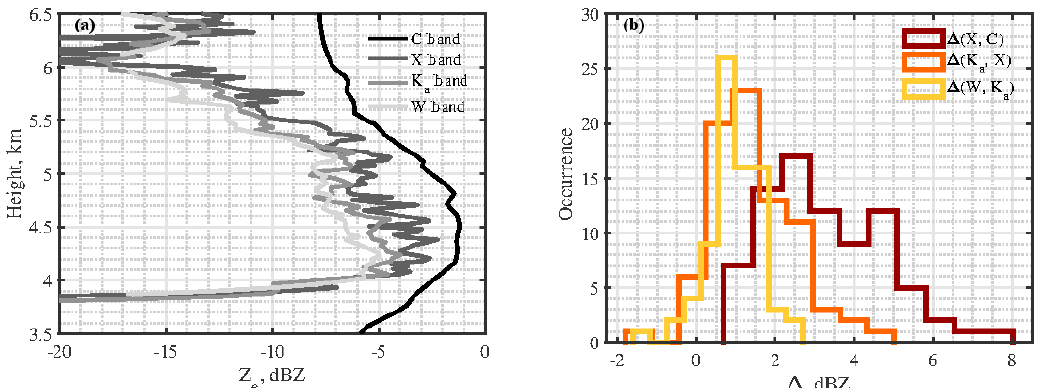
Figure 1. Panel (a) shows radar profiles at C, X, Ka and W band for 15 February 2014 at 17:13UTC where calibration is performed within the most stable height interval between 4 and 6km. Panel (b) shows calibration error histograms related to the differences ( (cid:49) ) between X- and C-band radars (dark red), Ka- and X-band radars (orange), and W and Ka radars (yellow).